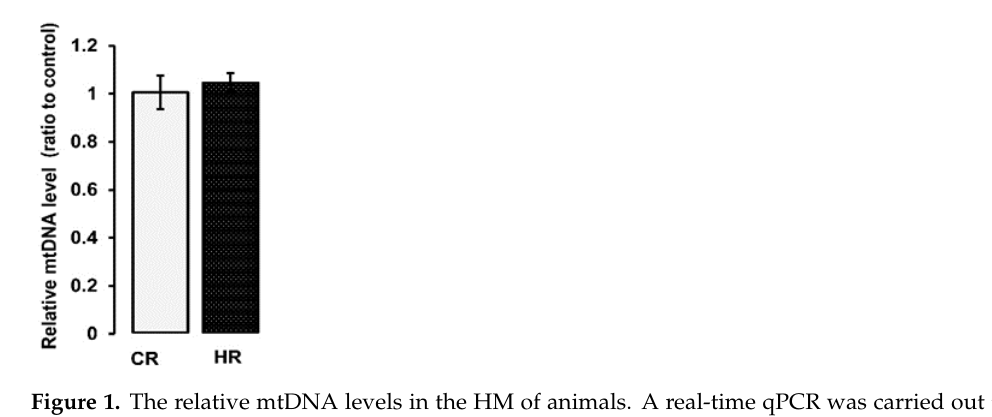
We estimated the functional state of rat heart mitochondria by measuring respiration rates in different metabolic states using NAD-/FAD-dependent substrates and TMPD (nonphysiological electron-donating compound)/ascorbate (Tables 2 and 3). As can be seen from Table 2, changes in the mitochondrial respiration rate of HR occurred only in state 4 (after all ADP was depleted). Accordingly, the respiratory control ratio (RCR) was reduced in heart mitochondria of hyperthyroid rats (HHM) by 15–20% (Table 2). Table 2. Respiration parameters of heart mitochondria of control and hyperthyroid rats.